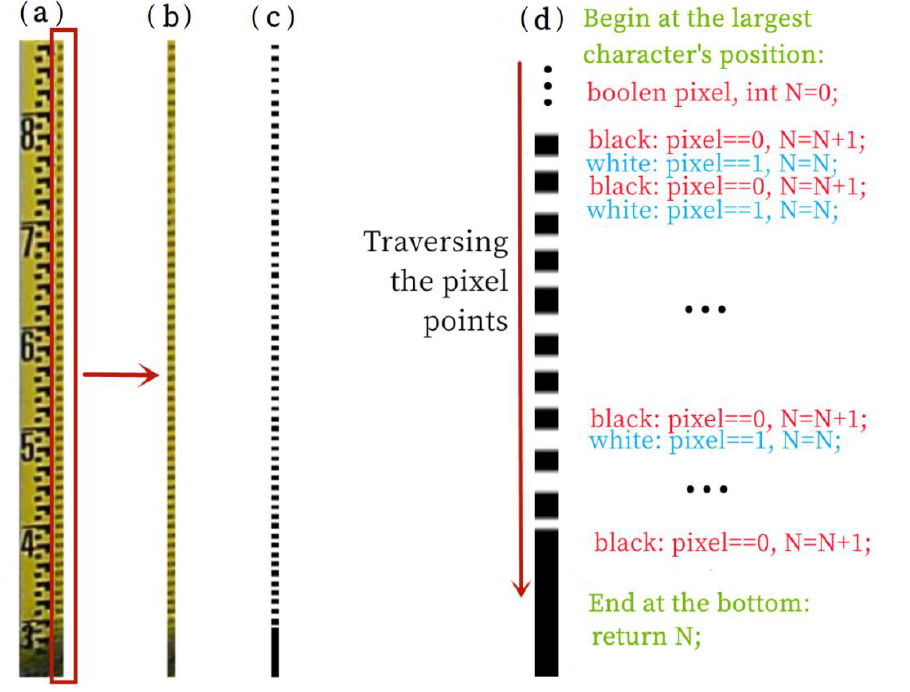
Figure 21. Flowchart and pseudo-code for calculating the number of scale lines. (b) is the portion of the scale extracted from (a) . (c) is the binarized image of (b) . (d) is the pseudo-code of the calculation procedure to obtain the number of scale-lines.